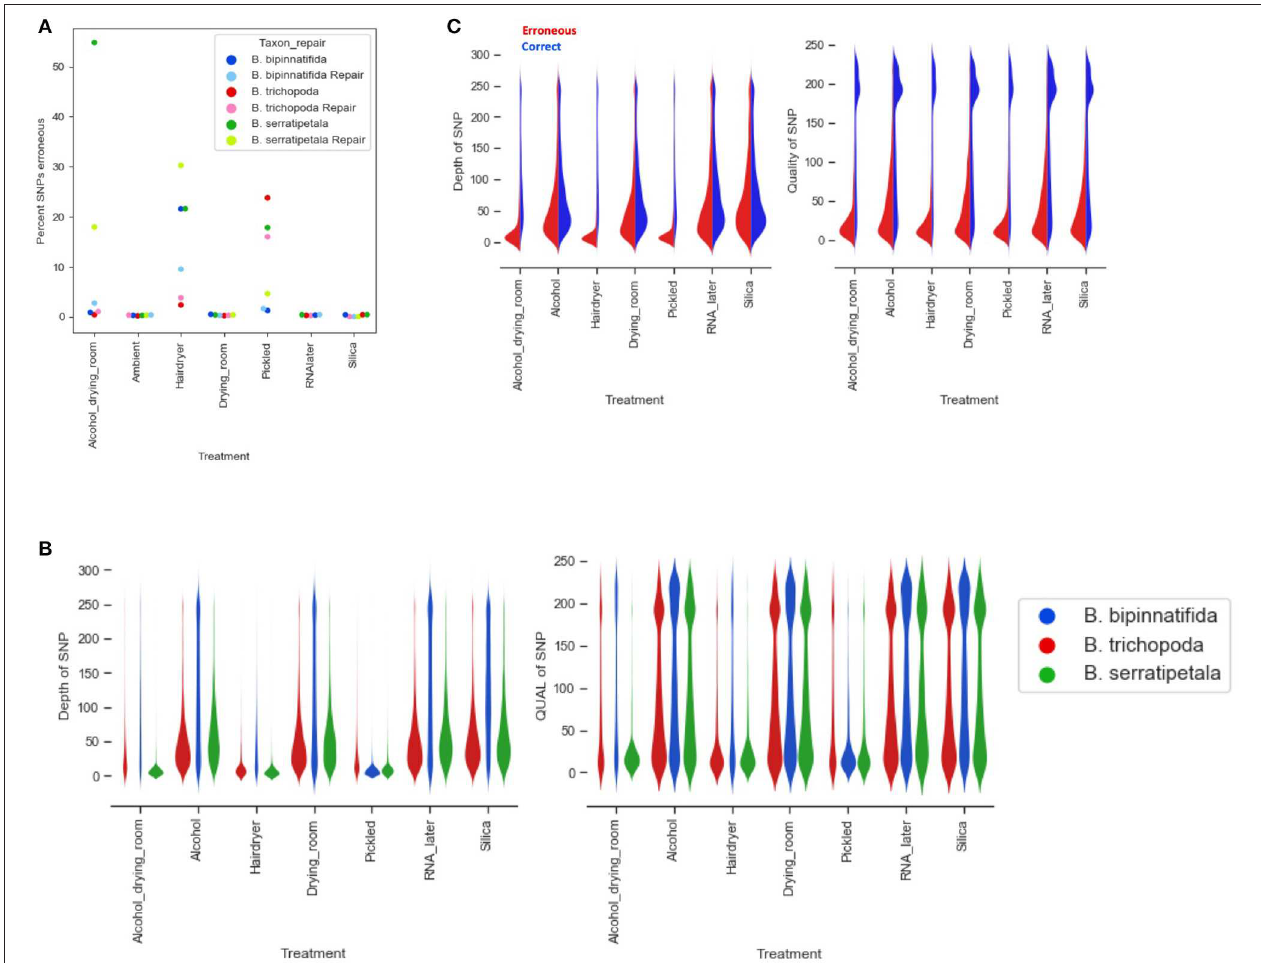
FIGURE 7 | Erroneous SNPs by species and treatment. (A) Percentage of erroneous SNPs by treatment (x axis) and by species (marker color). (B) Depth and quality of all SNPs called by treatment (x axis) and by species (plot color). (C) Depth and quality of SNPS called erroneously (red) and correctly (blue) by treatment.